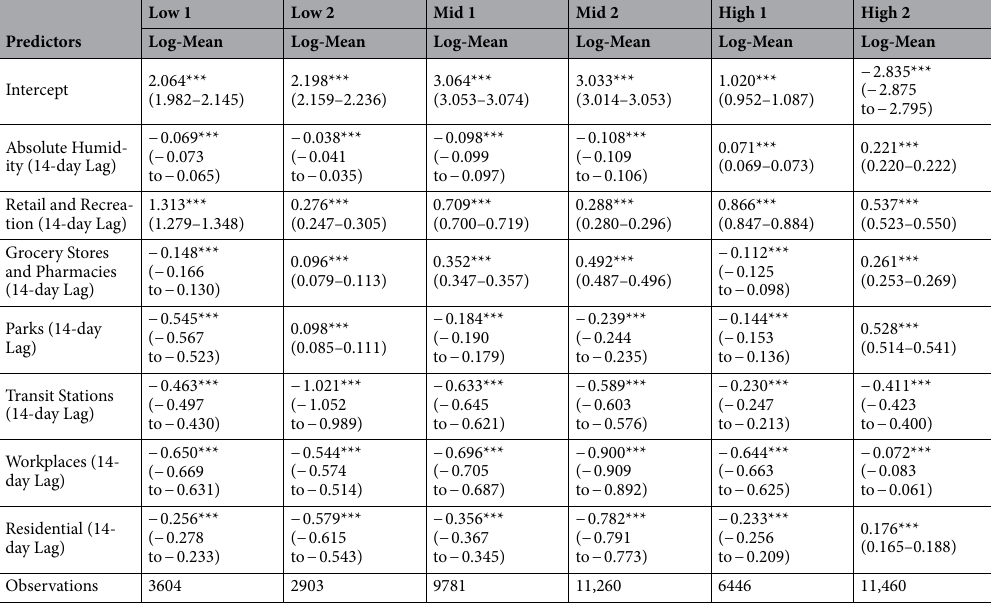
Table 2. Untransformed GLM coefficient estimates for the 2020 spring to fall period. Untransformed coefficient ( β ) estimates for GLM Regression against new cases per 100,000 from March 10, 2020 to September 30, 2021. The 95% confidence intervals are shown in parenthesis. Estimated coefficients for county-level fixed effects and epidemiological terms (immunity factor and lagged daily cases) are not shown. * p < 0.05 ** p < 0.01 *** p < 0.001.